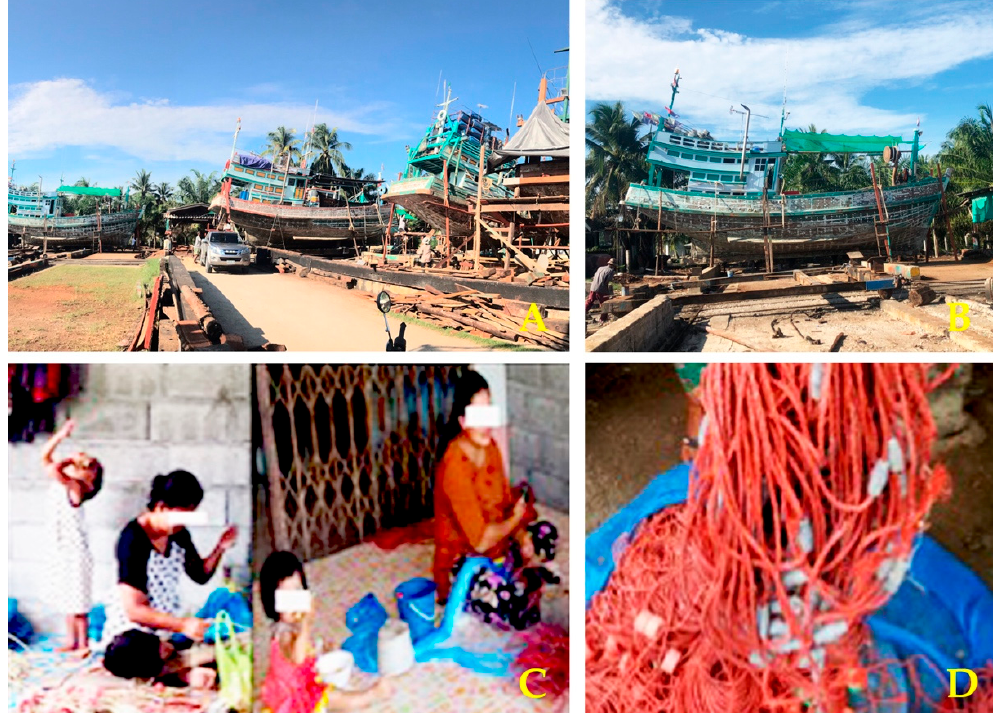
Figure 2. Boatyards, girls and working-at-home mothers, and a fishing net with lead weights. A total of 311 children were randomly selected from a fishing community in Pakpoon suburb, where repair boatyards existed ( A , B ). Girls were nearby while mothers were assembling lead weights to produce fishing nets ( C ). Approximately 180 lead weights are used to make a two-kg fishing net ( D ).